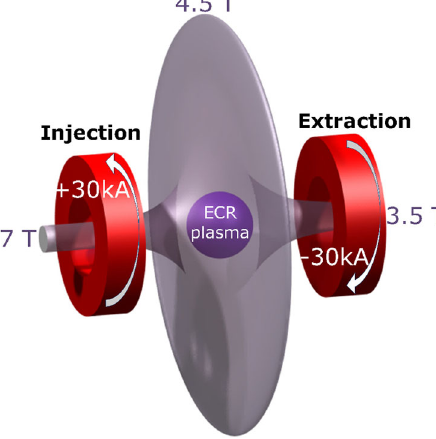
FIG. 27. Schematic view of the SEISM cusp magnetic trap.